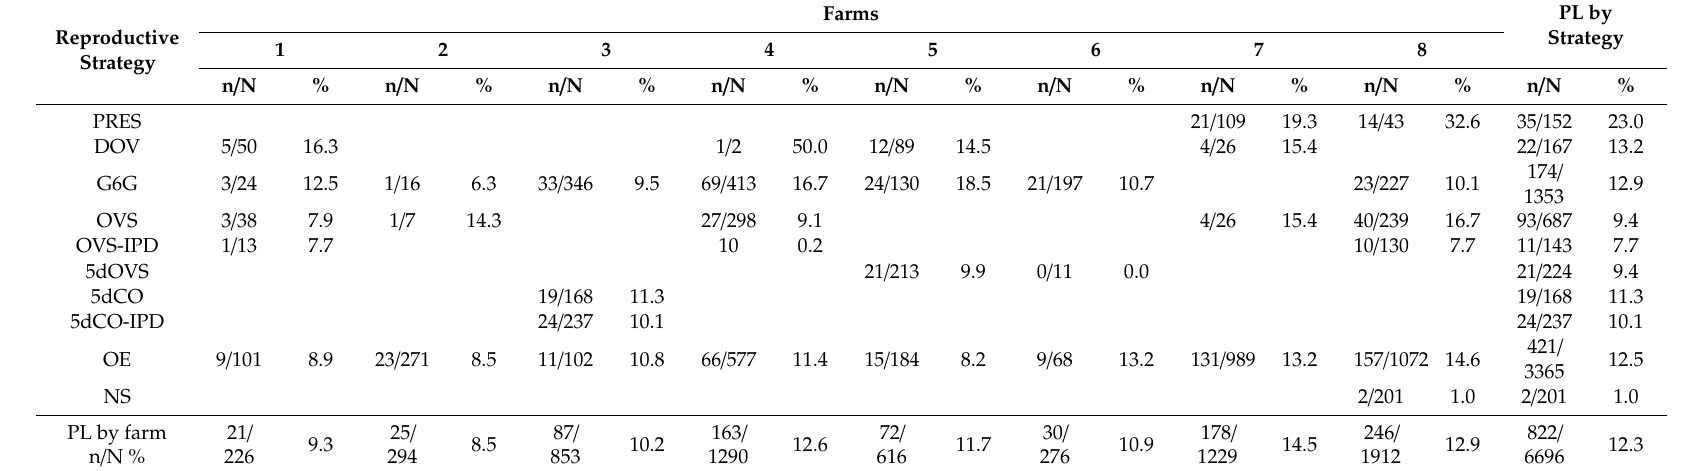
Table 4. Pregnancy loss descriptive statistics for the type of reproductive strategy across eight Spanish Holstein